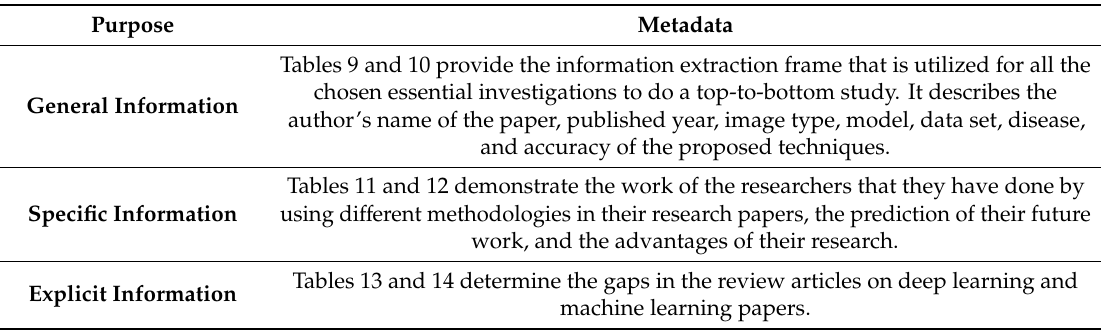
Table 5. Data extraction